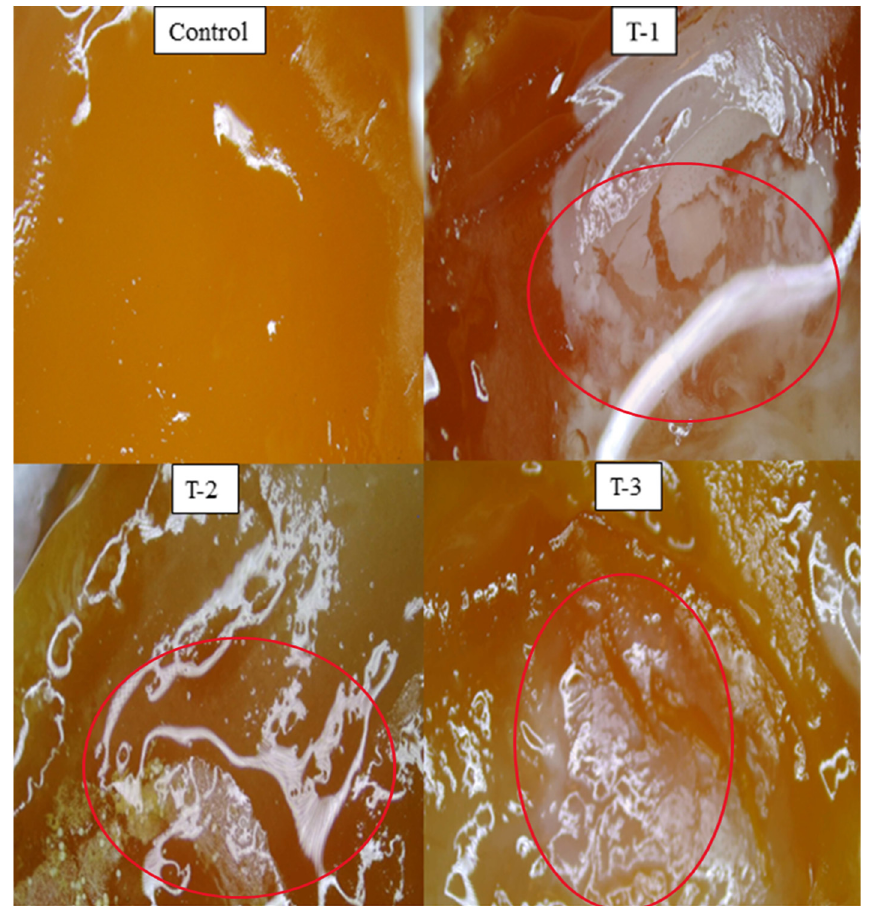
Figure 6. Microscopic images of fertilized eggs implanted with sodium alginate (SA)- Raphanus sativus L. seed extract (SE) hydrogels on day 14. Control, T-1: (SA:SE 70:30); T-2: (SA:SE 80:20); T-3: (SA:SE 90:10).